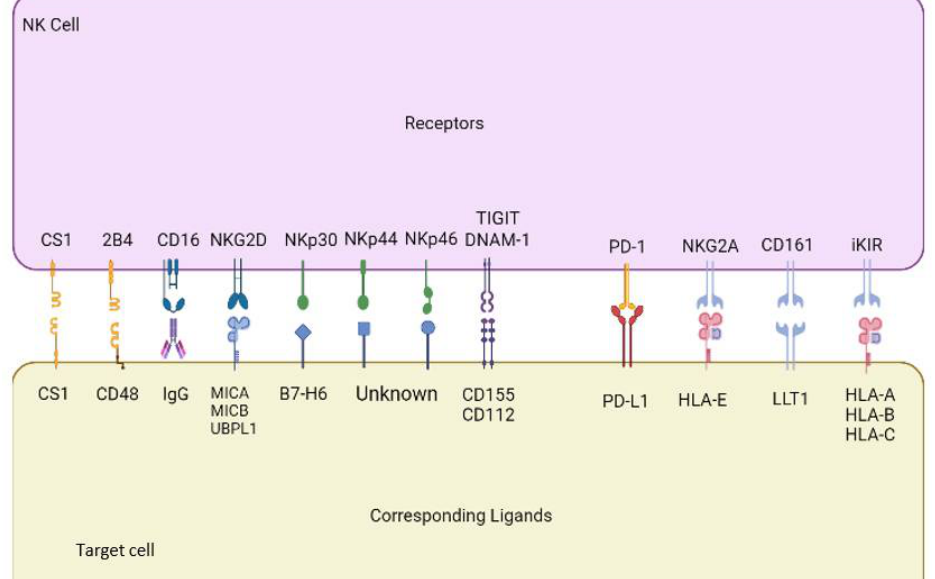
Figure 1. Several key NK cell receptors and corresponding ligands.